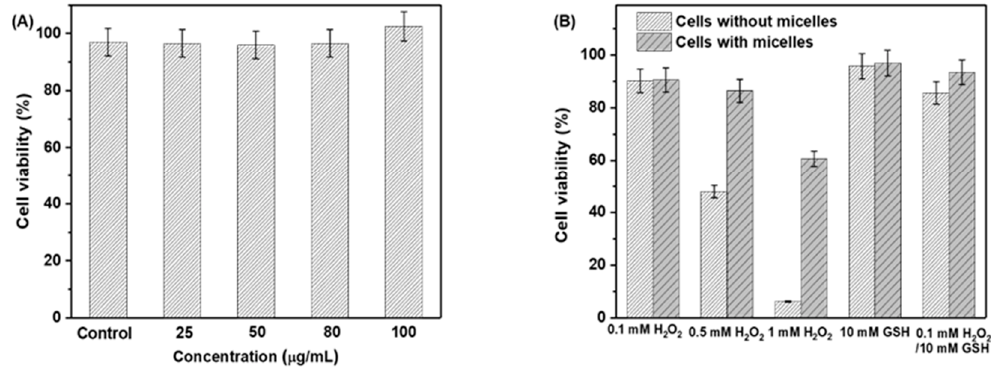
Figure 5. KB cell viability after incubation with different concentrations of gemini mPEG-Cys-PMT micelles for 24 h ( A ) and in vitro cell viabilities of KB cells overlaid with gemini mPEG-Cys-PMT micelles (0.1 mg/mL) cultured with different concentrations of H 2 O 2 and 10 mM GSH-OEt ( B ). Data are presented as mean ± SD of three independent experiments.